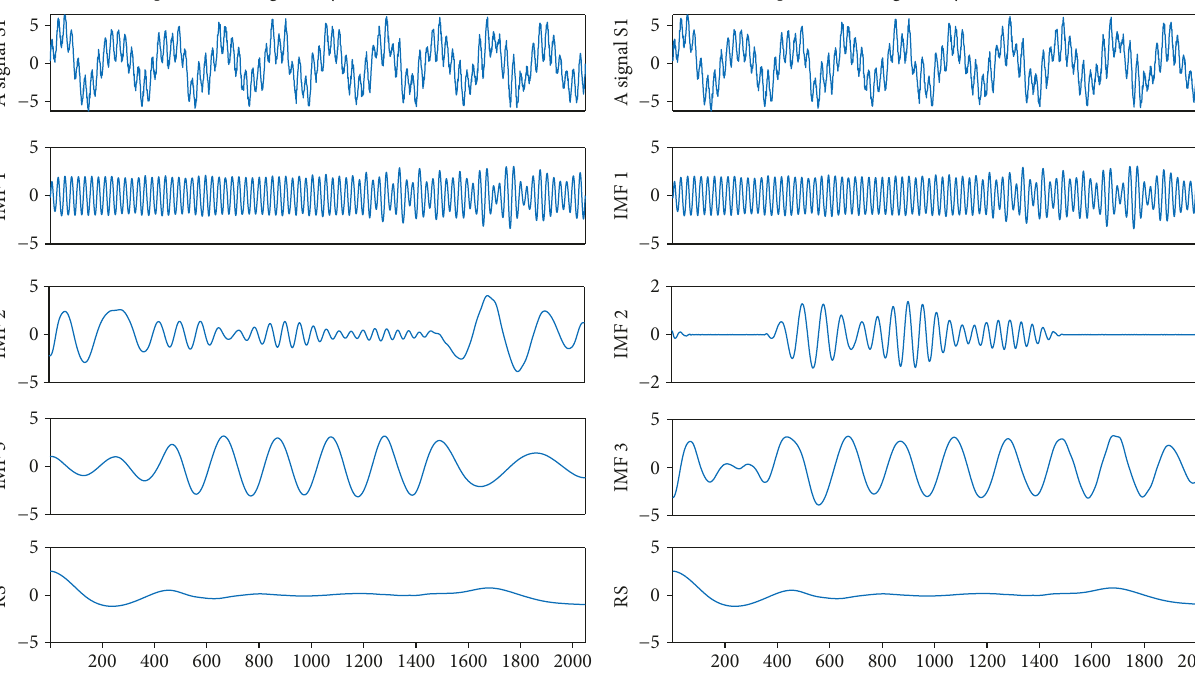
via the PEEMD method τ = 4, 1 1